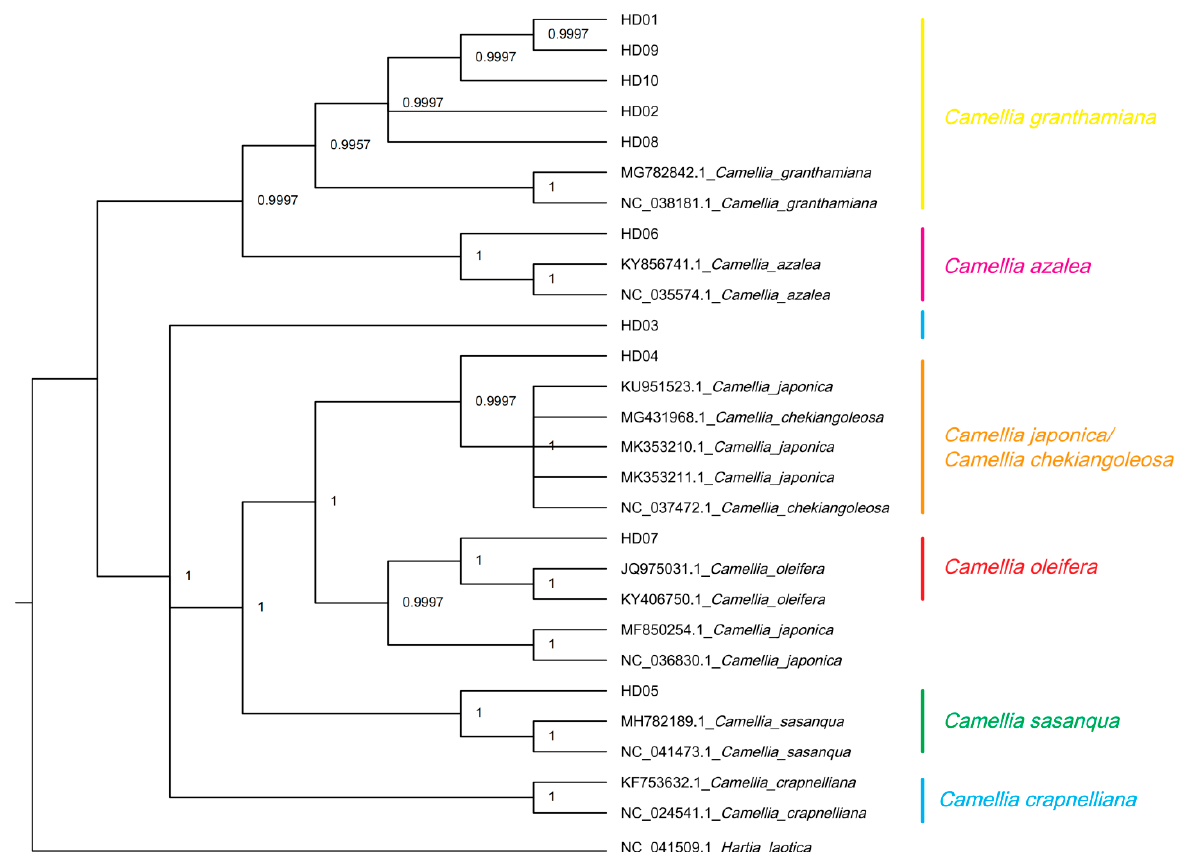
Figure 7. Phylogenetic tree of 13 samples based on CDS using the MrBayes method (BI).